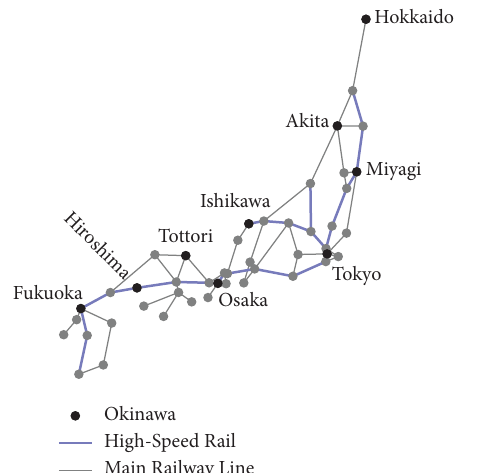
Figure 9: Spatial location of each prefecture (using latitude and longitude angles).